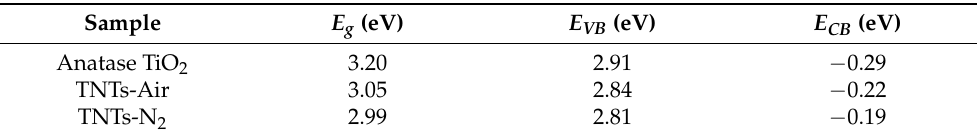
Table 1. Calculated E CB , E VB and E g of TNTs annealed in nitrogen and air compared with anatase TiO 2 from [55].